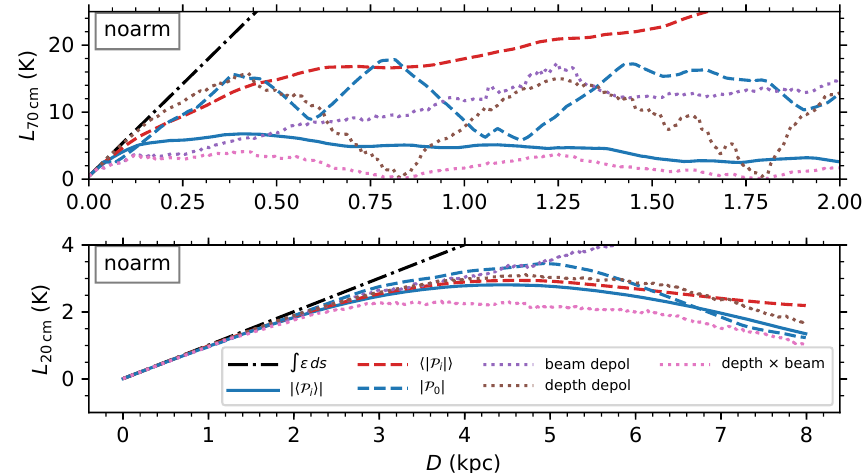
Figure 5. Blue lines are as in Figure 4: polarized intensity for the full beam |(cid:104)P i (cid:105)| (blue solid line) and in a representative sightline within the beam |P 0 | (blue dashed line) from the noarm model as a function of D . I also show the mean of |P i | , (cid:104)|P i |(cid:105) , of the N = 25 individual sightlines (red dashed line). Dotted lines show analytic models of beam depolarization (Equations (6) and (7)), depth depolarization (Equation (4)), and both. Note that in the top (70cm) panel, I show only the first 2kpc because depolarization effects become dominant on shorter distance scales at the long